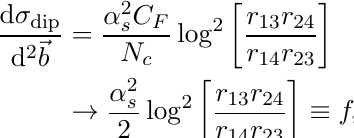
Figure 1. Schematic view of two colliding gluon dipoles. The initial dipoles denoted r are allowed to interact via two-gluon exchange. This results in the creation of two new dipoles, r 14 and r 23 and a connection of the two dipole chains. The lines r 13 and r 24 are not drawn, but enters in eq.